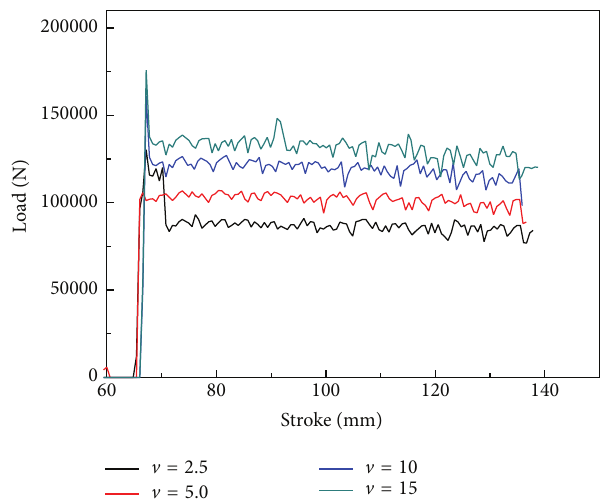
Figure 8: The die load with different extrusion velocity.